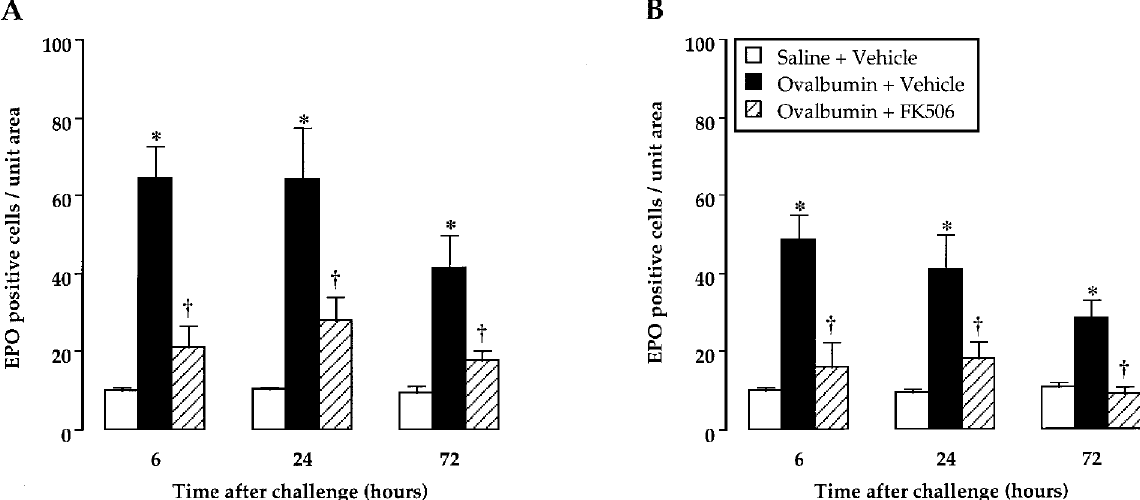
FIG. 3. Effect of FK506 on antigen-induced eosinophil infiltration in the bronchial mucosa from sensitized guinea-pigs. EPO + cells in the bronchial submucosa (panel A) and in the adventitia (panel B) of sensitized guinea-pigs challenged with intranasal saline or ovalbumin and treateds.c. with 0.5mg/kg of FK506, 1h before and 5h after antigen challenge. Animals were challenged and lungs removed 6, 24 or 72h thereafter. Results are means ± SEM of six experiments. * P < 0.05, compared with